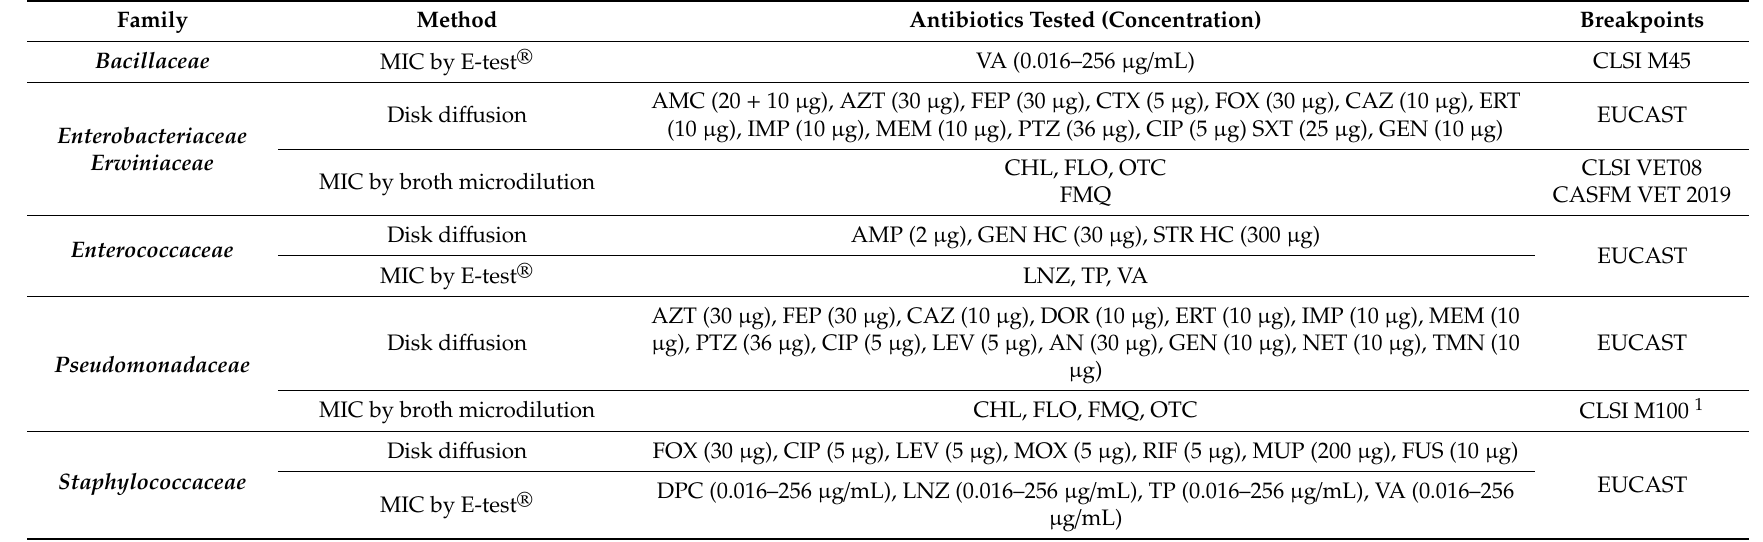
Table 2. Antibiotics used for antibiotic susceptibility testing and respective concentrations and breakpoints by bacterial